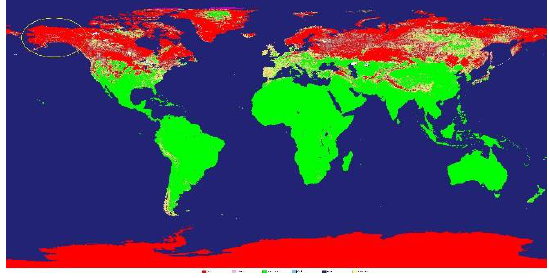
Figure 4. Snow cover areas are shown in red and Alaska is shown here by elliptic acquired by MODIS.